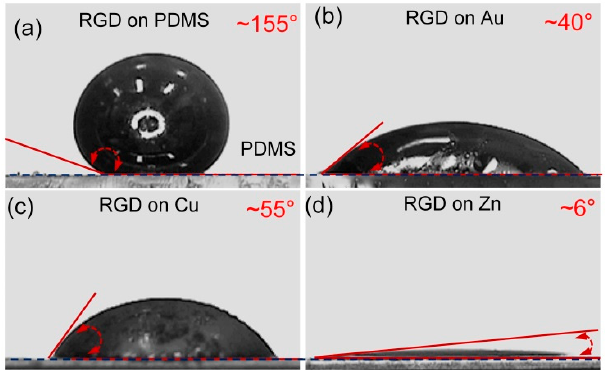
Figure 3. Photographs of static contact angles of the RGD on various substrates (( a ) PDMS, ( b ) Au, ( c ) Cu and ( d ) Zn). ( c ) Cu and ( d )